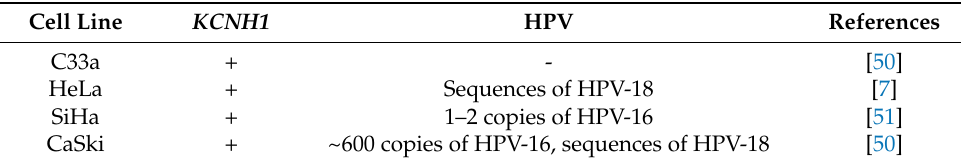
Table 4. Expression of KCNH1 and HPV-oncogenes in cervical cancer cells. Cell